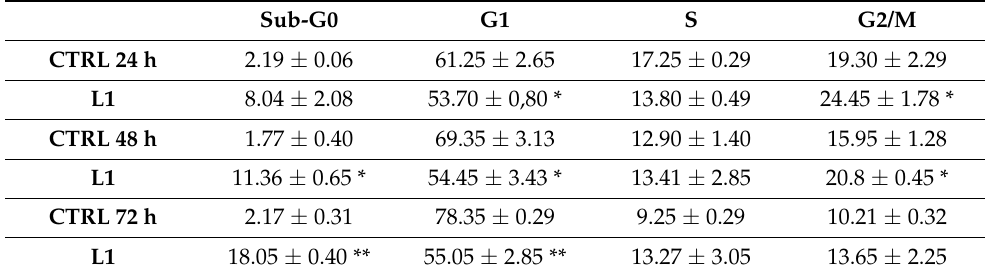
Table 1. Cell Cycle Analysis of HeLa Cells after 24 h, 48 h, and 72 h Incubation with